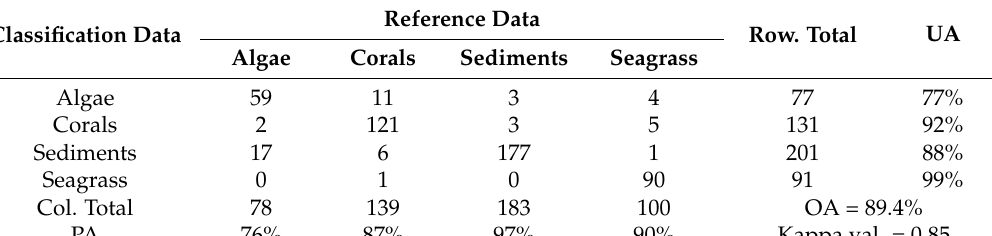
Remote Sens. 2018 , 10 , x FOR PEER REVIEW